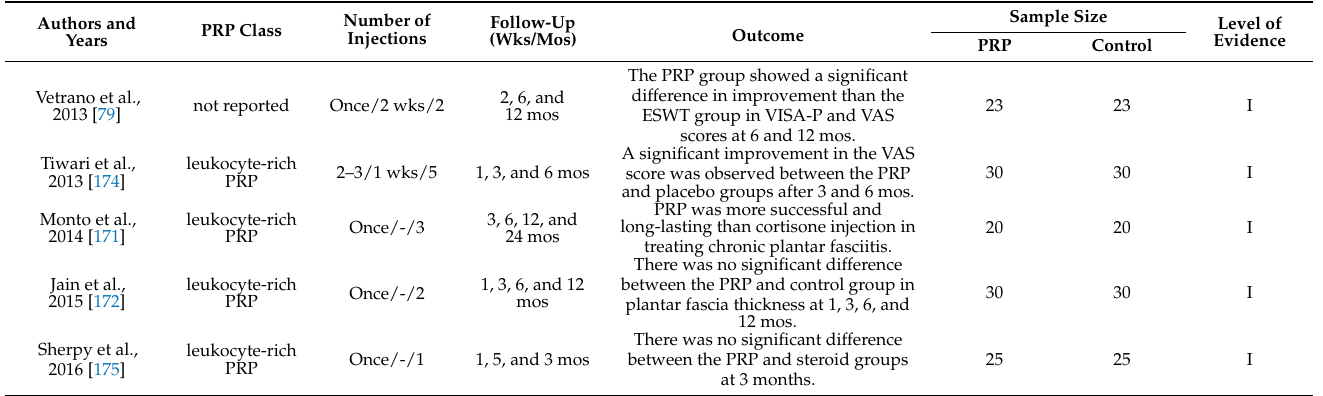
Table 4. Studies on the use of PRP application in foot and ankle for Plantar